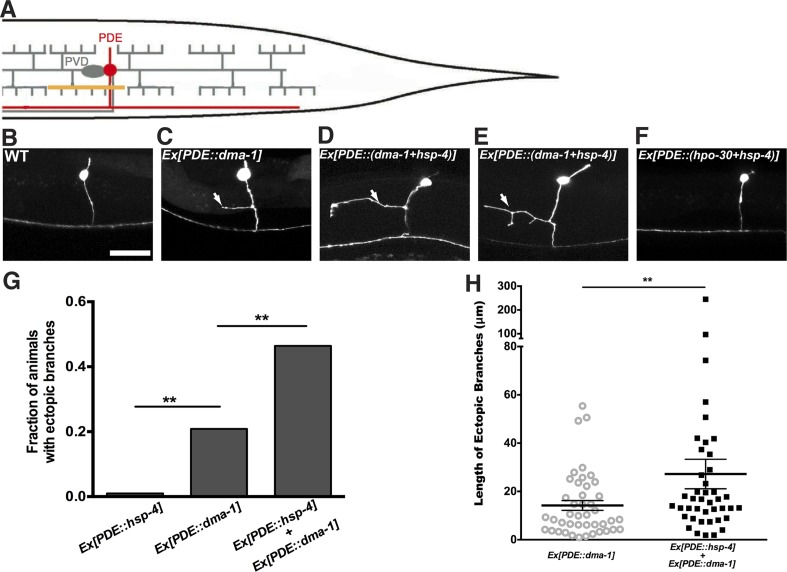
Expression of dma-1 and hsp-4 together in the morphologically simple PDE neurons can induce ectopic branching more dramatically.(A) Diagram showing the PDE neuron (in red) which is located close to the PVD cell body and has a simple processes running adjacent to the PVD dendrites. Orthogonal ectopic branching (in orange) at a stereotyped position in the PDE commissure, reminiscent in location and direction to PVD tertiary branching. (B to D) Representative dendritic morphology of PDE neurons expressing cytoplasmic GFP in wild-type (B), a strain with expression of dma-1 (C) and a strain with co-expression of dma-1 and hsp-4 in PDE (D). Scale bar, 20 μm. Arrows, orthogonal ectopic branches. (E) More dramatic ectopic branching in the same strain co-expressing dma-1 and hsp-4 in PDE. (F) No ectopic branching in the same strain co-expressing hpo-30 and hsp-4 in PDE. (G) Percentages of PDE ectopic branching in strains expressing hsp-4 only, dma-1 only, and dma-1 with hsp-4. n > 100. **p < 0.01, χ2 test with Sidak correction. (H) Length of PDE ectopic branches in the strains expressing dma-1 only, and dma-1 with hsp-4. **p < 0.01, Mann Whitney U-test.